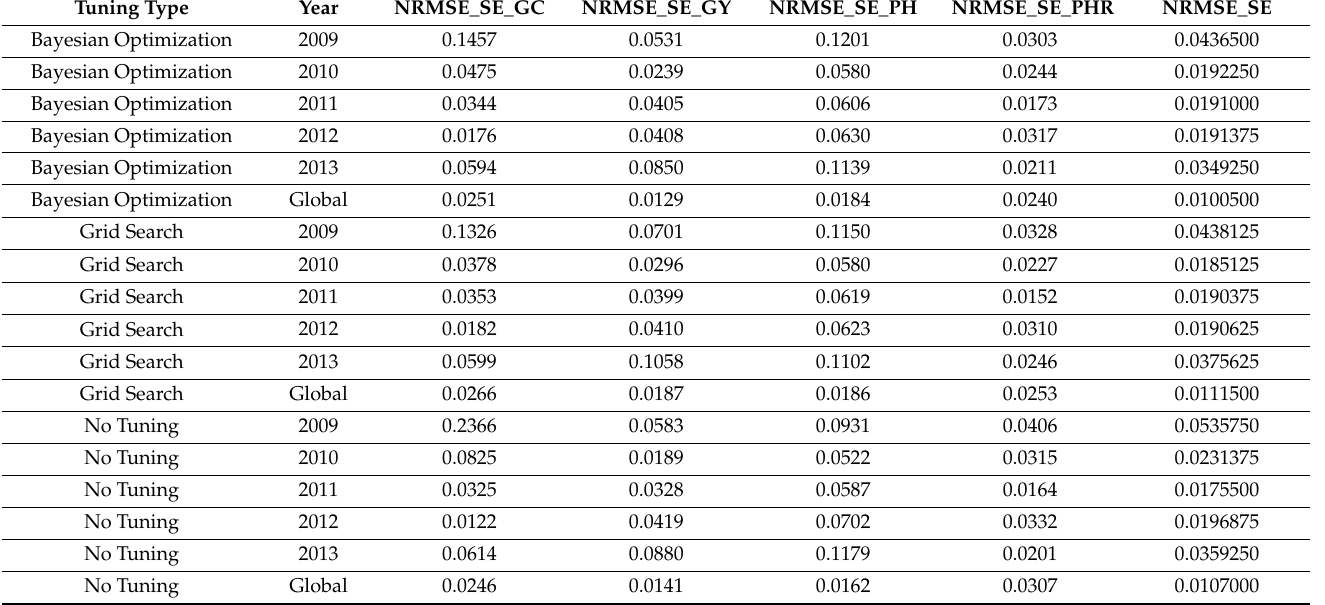
Table A4. The standard error of prediction performance for each year and across years (Global) of the dataset 1 (Japonica) in terms of normalized root mean square error (NRMSE) under three methods of tuning (BO, GrS and NT). RE denotes relative